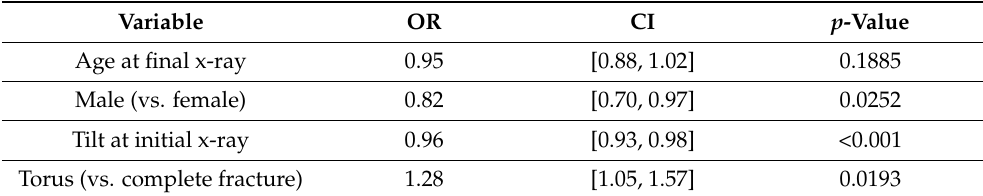
Figure 4. Comparison of the anterior tilt angles between the fractured and the healthy leg at the final x-ray among children with trampoline fractures of the tibia. After remodeling, the anterior tilt angle in the injured leg is still larger than on the opposite healthy leg, as shown here by the majority of anterior tilt angle values ( black dots ) above the bisecting blue line. Table 5. Factors associated with lack of remodeling at one year (anterior tilt angle > 0 ◦ at the final exam) after a trampoline fracture of the tibia.